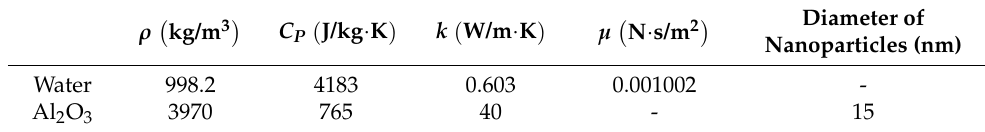
Table 1. The thermo-physical properties of water at 20 ◦ C [45] and of nanoparticles [46]. (cid:0) kg/m 3 ρ